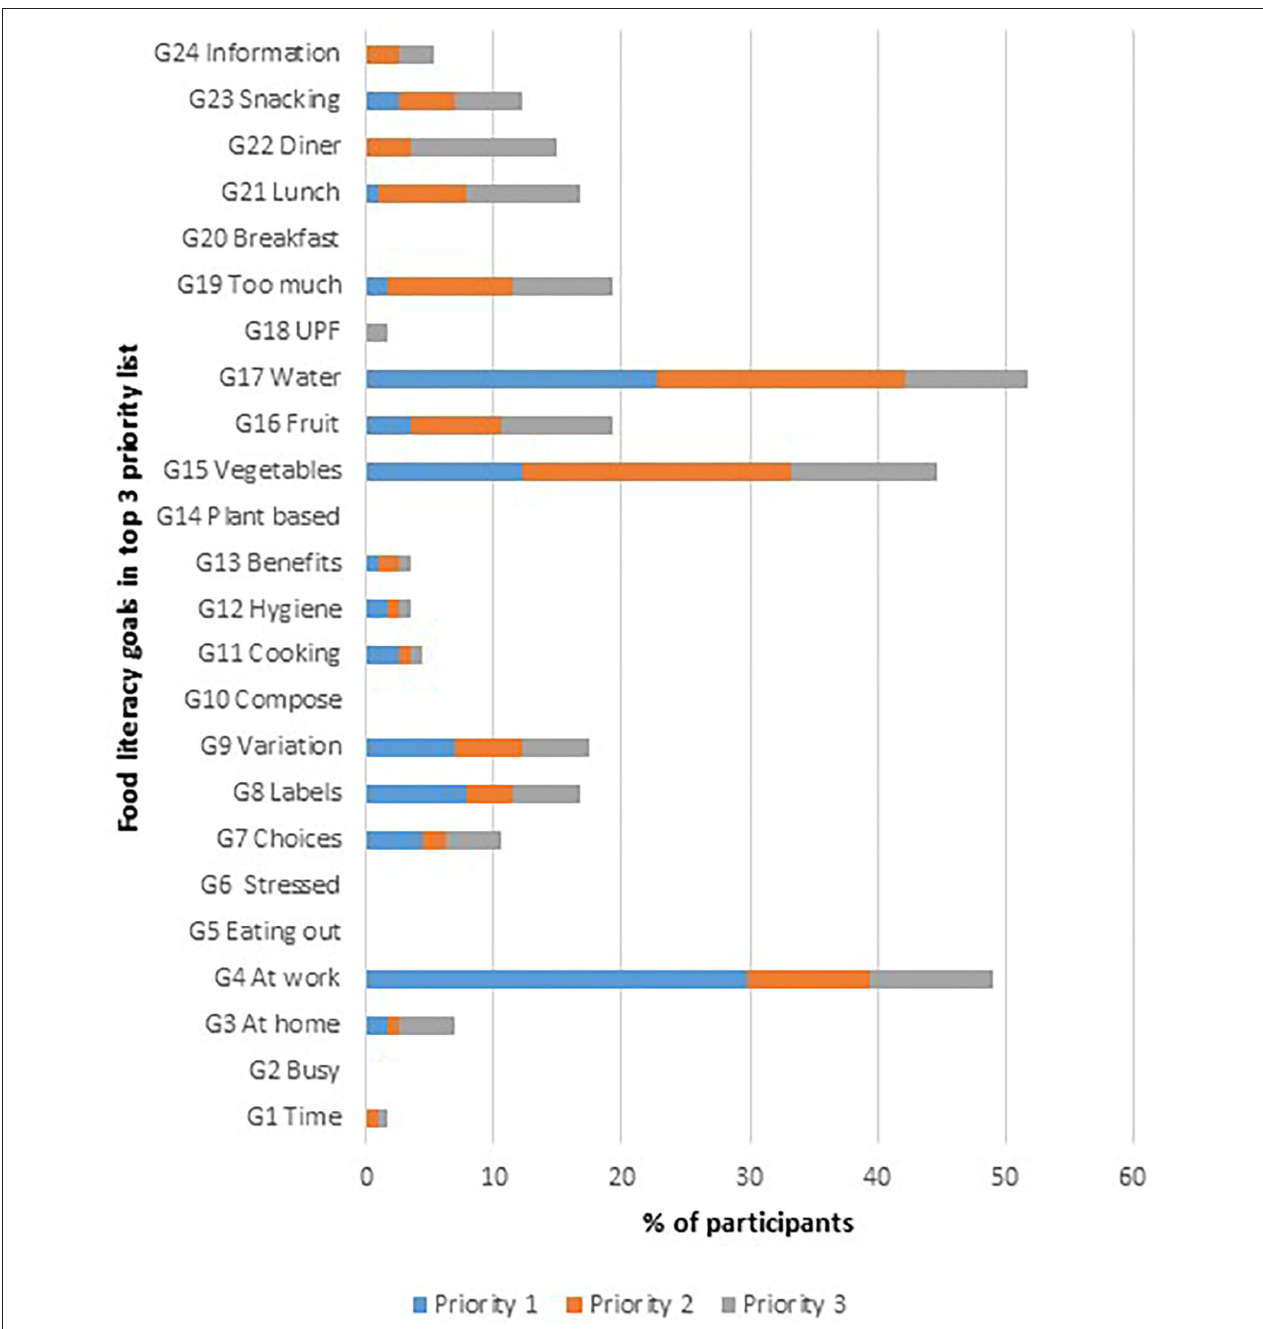
FIGURE 3 | Top 3 Priority list of food literacy goals calculated with the IFLT ( n = 114).